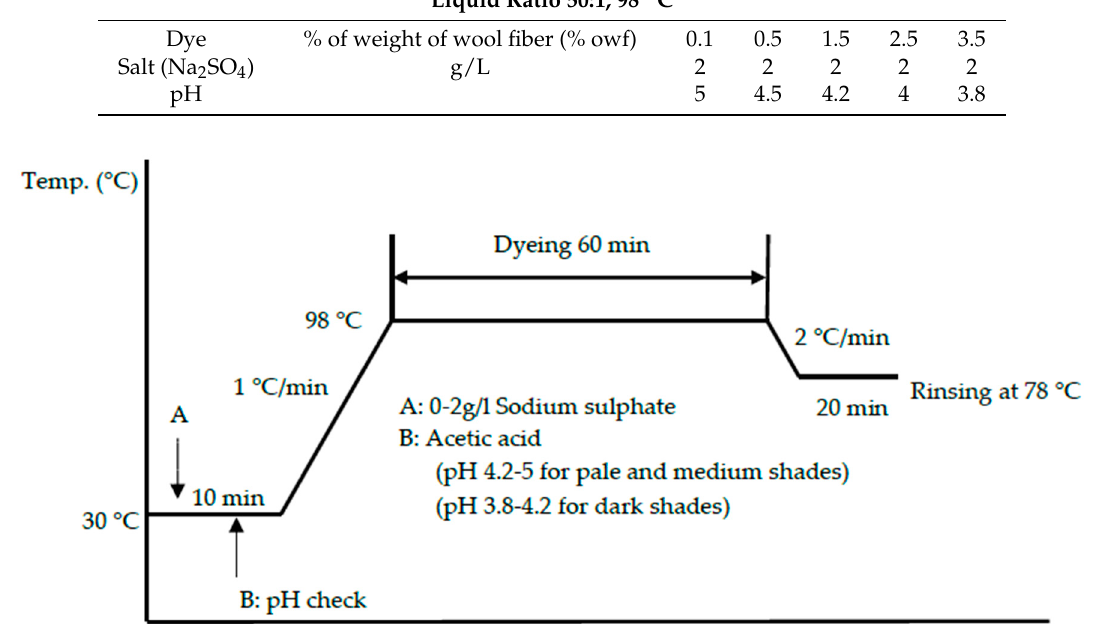
Figure 1. Profile of the conventional dyeing approach with salt.